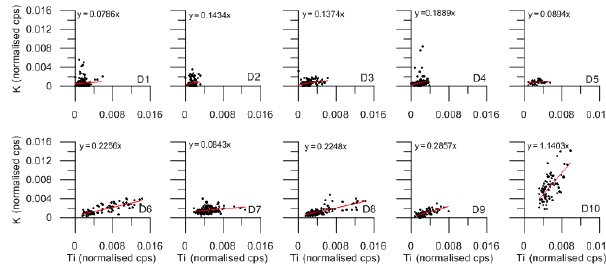
Figure 6. Correlation graphs and gradients of normalised Ti versus normalised K for each of the dust events